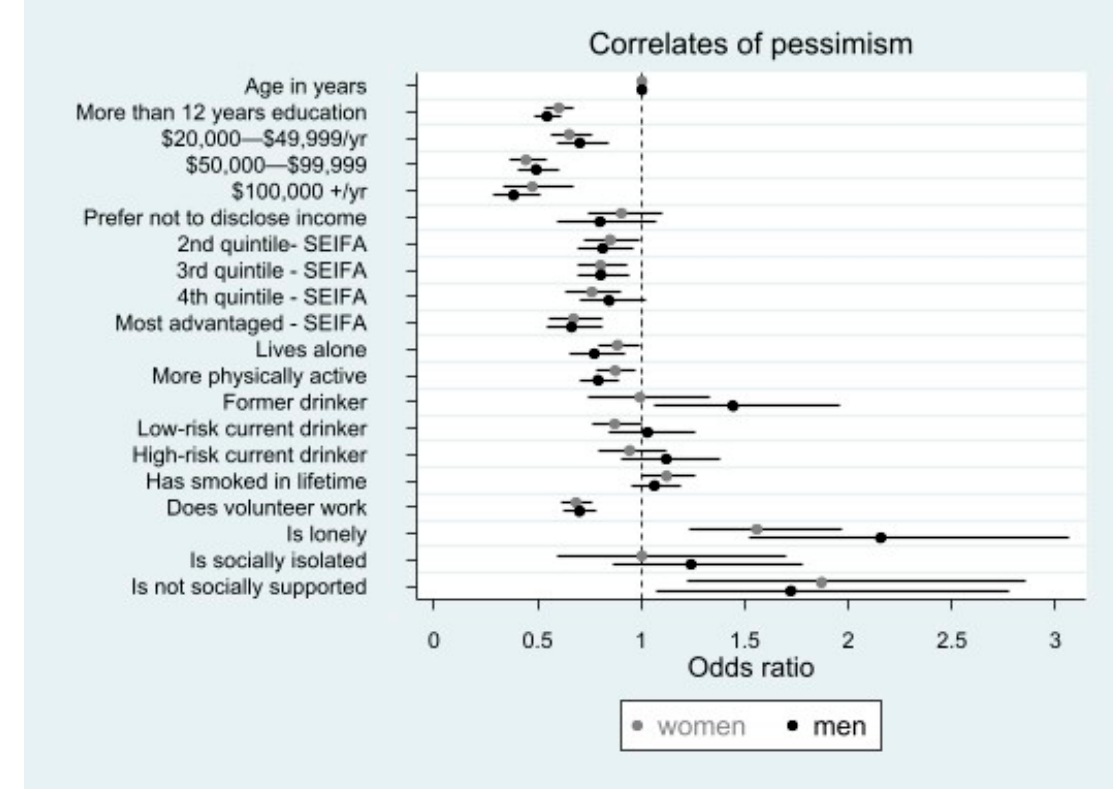
Figure 2. The association of socio-economic, behavioural, and social health factors with pessimism in 10,146 men and women aged ≥ 70 years: the results of multivariable ordinal logistic regression. Footnote: Horizontal bars present 95%CIs. SEIFA: socio-economic indexes for areas referent categories in order of variable appearance in the figure: <12 years education, <AUD 20,000/year, least advantaged, lives with others, less physically active, never drinks alcohol, never smoked, no volunteer work, not lonely, not socially isolated, and socially